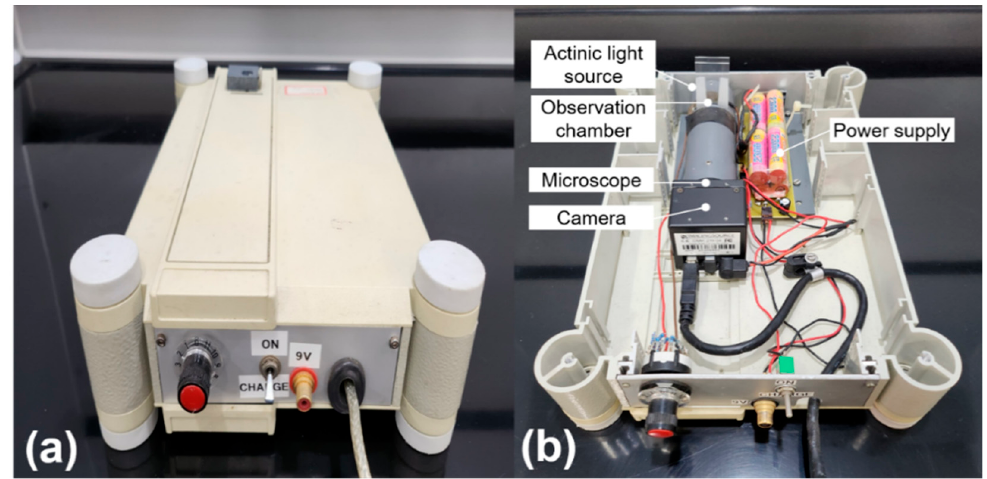
Figure 1. Overview of the Ecotox equipment ( a ) and the main hardware elements ( b ): The Euglena cell suspension is filled into an observation chamber consisting of two separate slides and inserted into a slot at the top of the device.